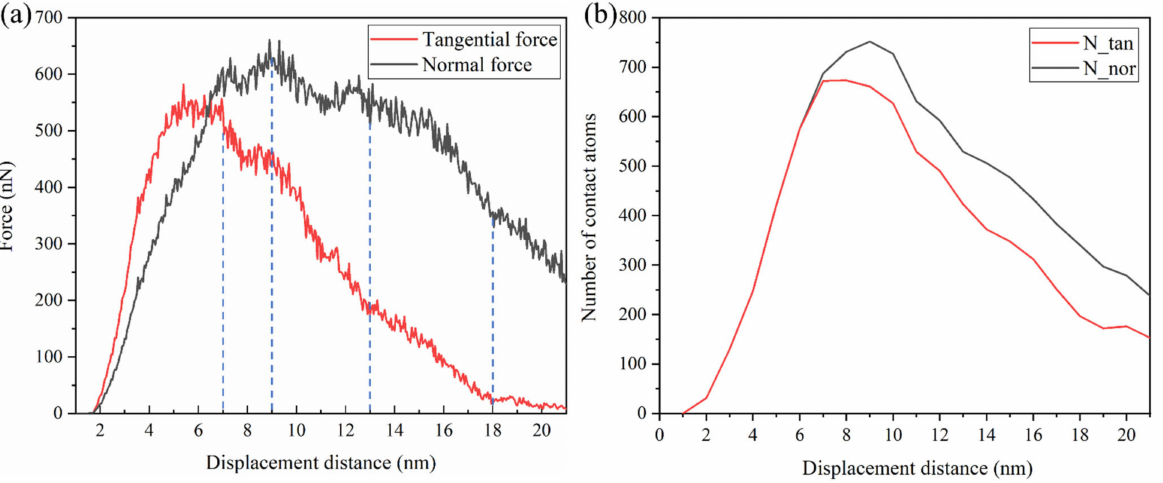
Figure 7. ( a ) The force–plowing length curves and ( b ) the number of contact atoms in the normal and tangential